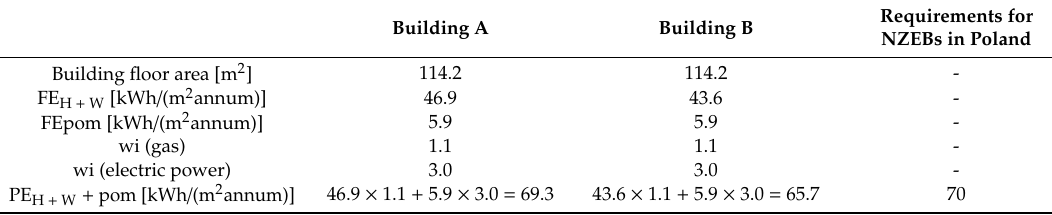
Table 8. Demand for di ff erent types of energy for type A and type B buildings